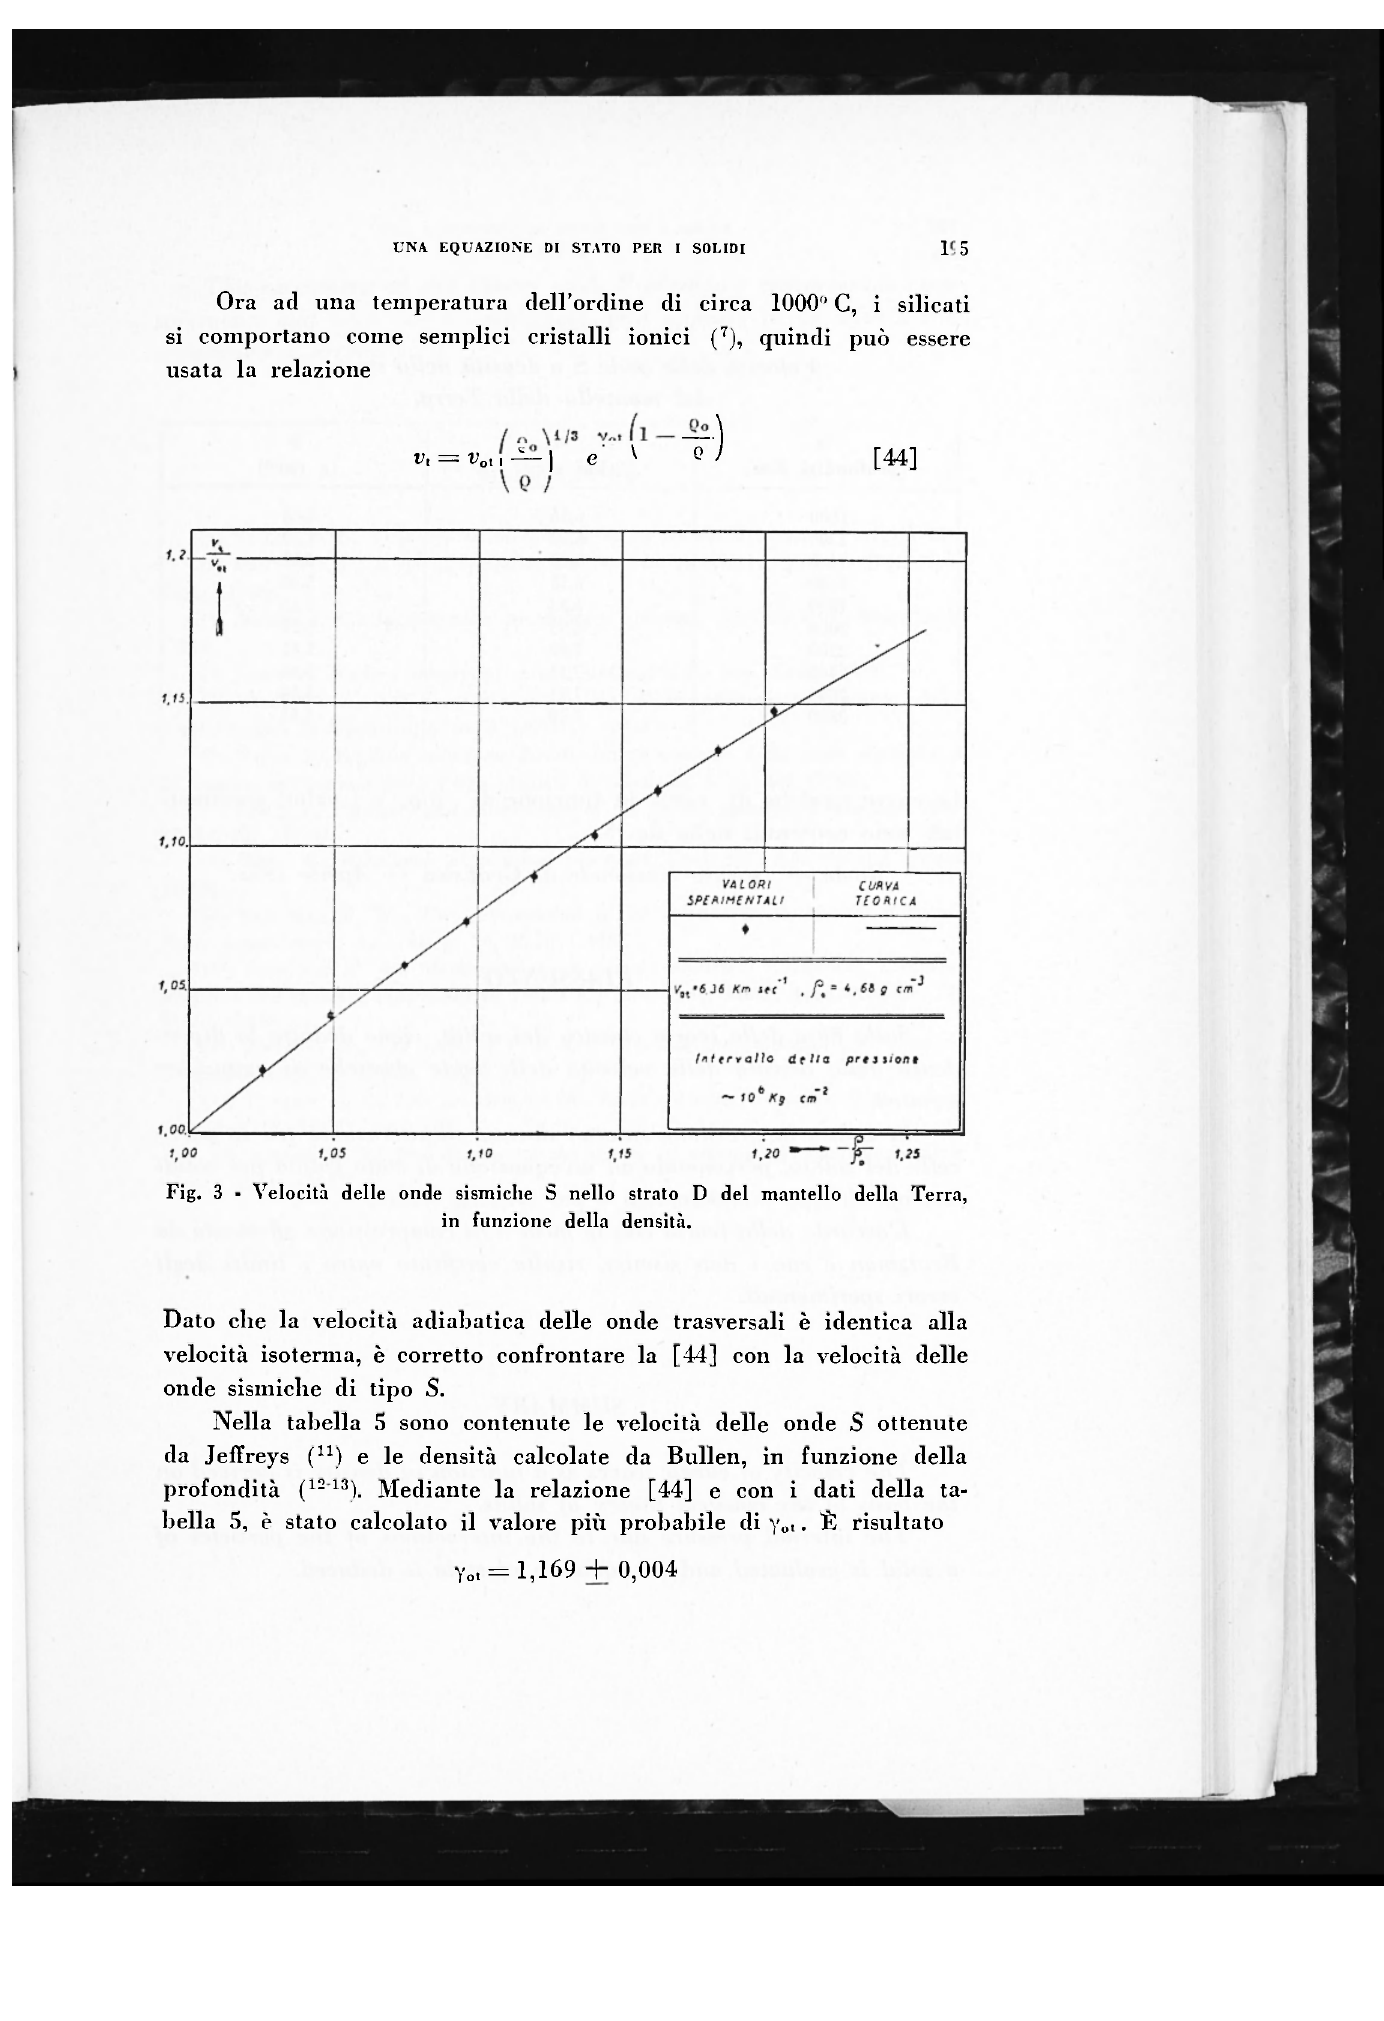
Fig. 3 - Velocità delle onde sismiche S nello strato D del mantello della Terra, in funzione della